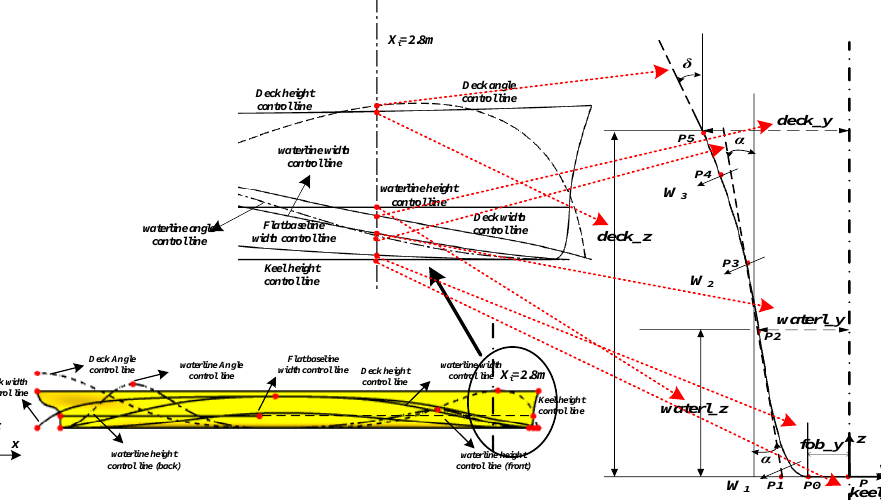
Figure 15. Schematic diagram of the correlation process between the longitudinal feature curve and cross-section curve ( X i = 2.8 m position).